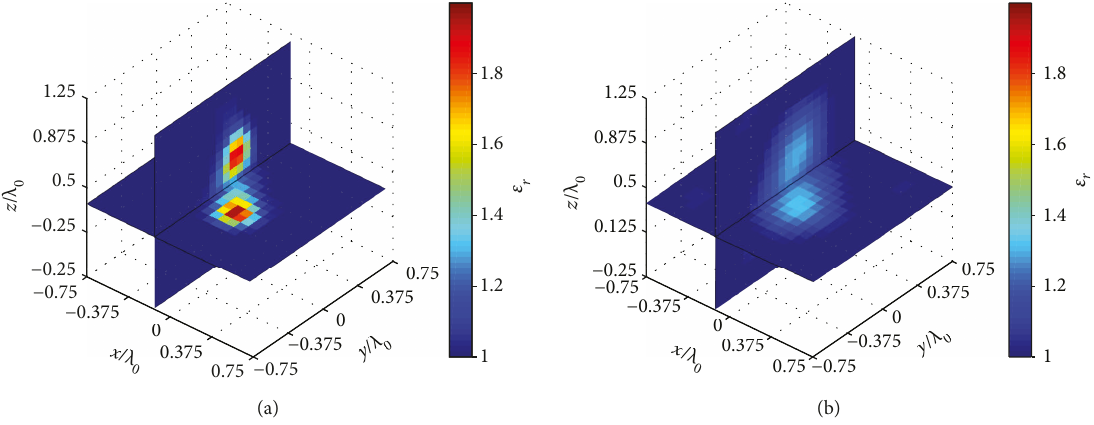
Figure 15: Reconstructed distributions of the dielectric permittivity with (a) p = p